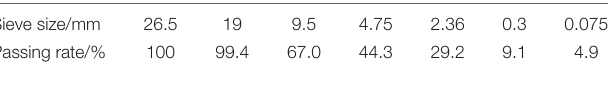
TABLE 1 | Passing rate of the key sieve for the design mixture.